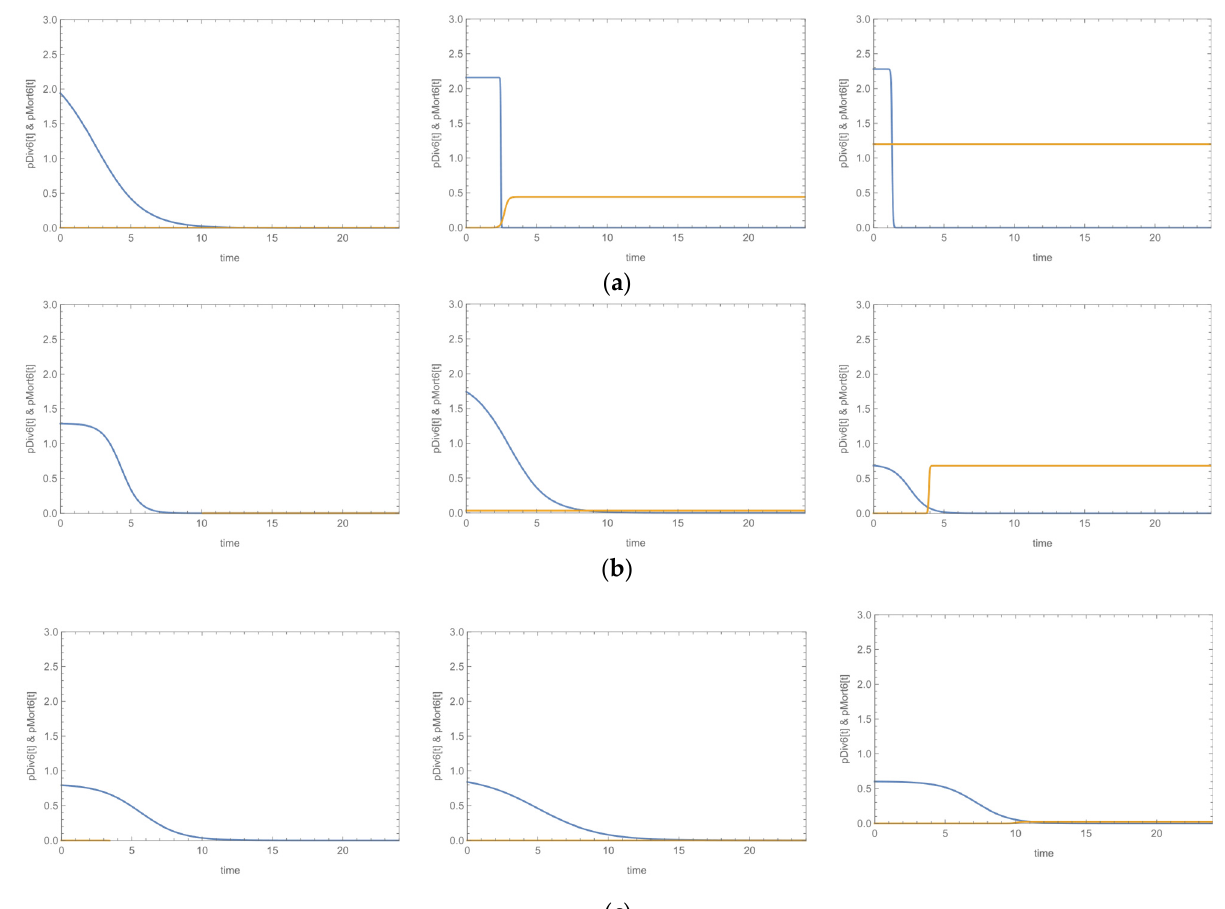
Figure 3. Representative plots of division (blue) and mortality (orange) probabilities of three strains: strain in TSB (left), strain + PLC (10 4 pfu/mL, center), strain + PHC (10 6 pfu/mL, right) versus time; ( a ) S. aureus , biofilm-positive, both concentrations of bacteriophage produced inhibitory effects; ( b ) S. aureus , biofilm-positive, only the high concentration of bacteriophage produced inhibitory effects; ( c ) S. epidermidis , biofilm-negative, no inhibitory effect was induced by bacteriophage.